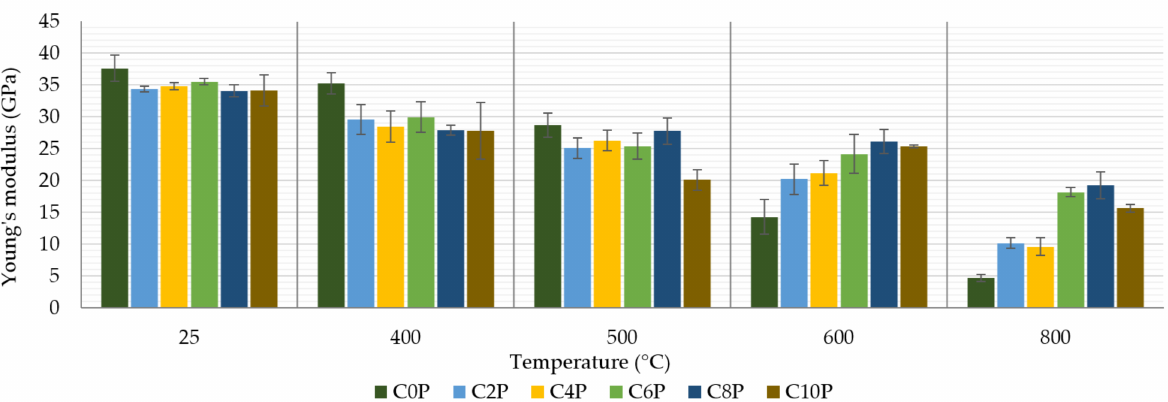
Figure 9. Young’s modulus of prepared composite